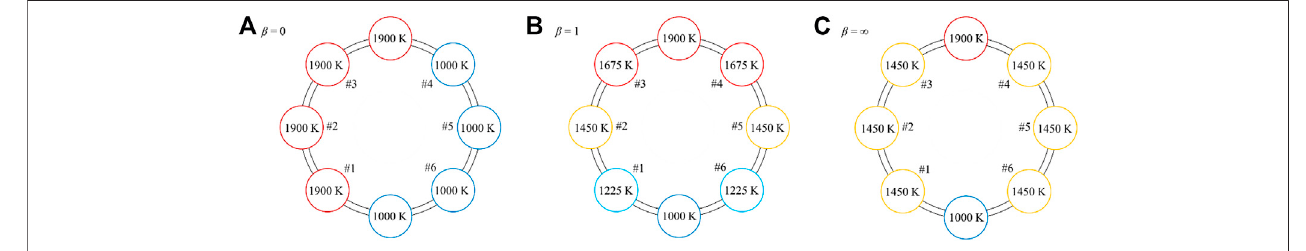
FIGURE 6 | Steady-state temperature distributions in the CRR array at the end of a cycle for (A) β (cid:2) 0, (B) β (cid:2) 1, and (C) β (cid:2) ∞ .